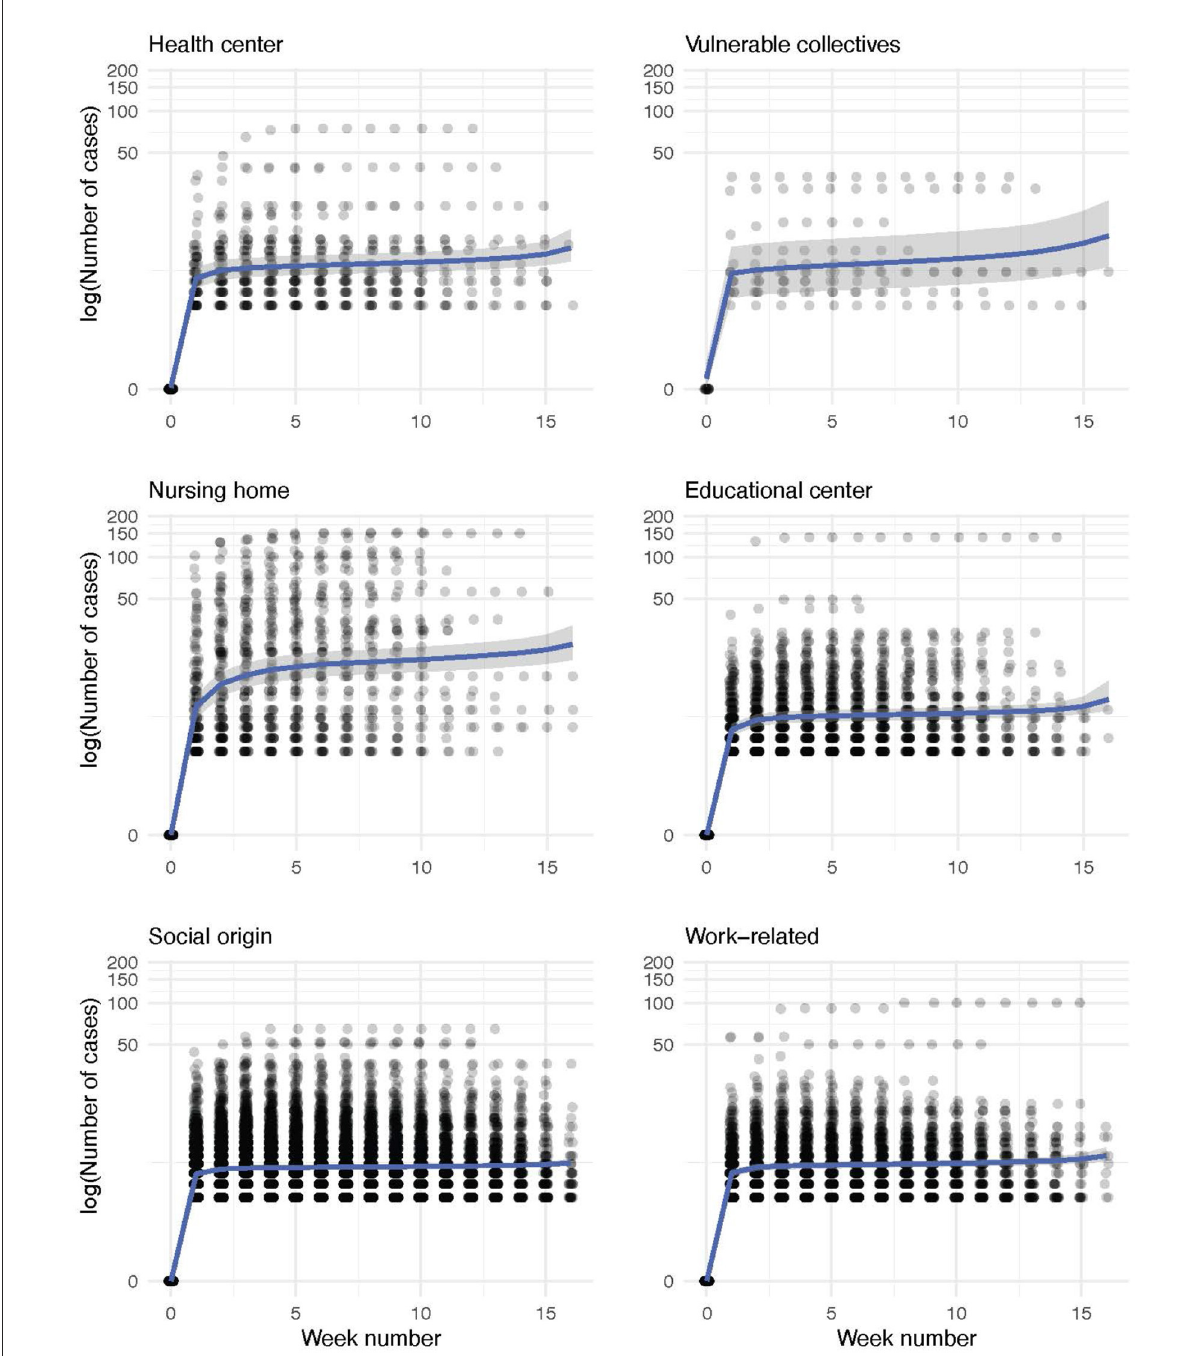
FIGURE8 Conditional effect plots of the negative binomial models for the weekly evolution of the number of within-outbreak cases for each infection source. The number of cases of each outbreak is represented in a logarithmic scale (experimental data, shown as dots). Shadowed in gray, we depict the range that comprises the 95% credible interval of the expected value by the model, whose parameters are shown in Table